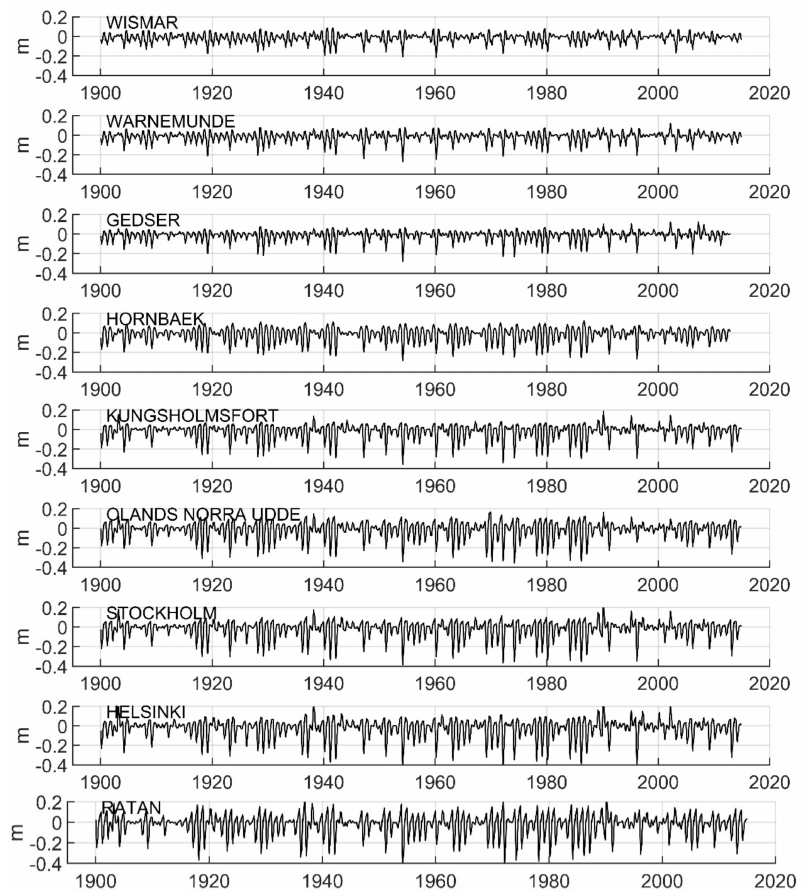
Figure 13. Annual sea level (m) estimated from tide gauges for the period 1990–2012 using CSEOF first